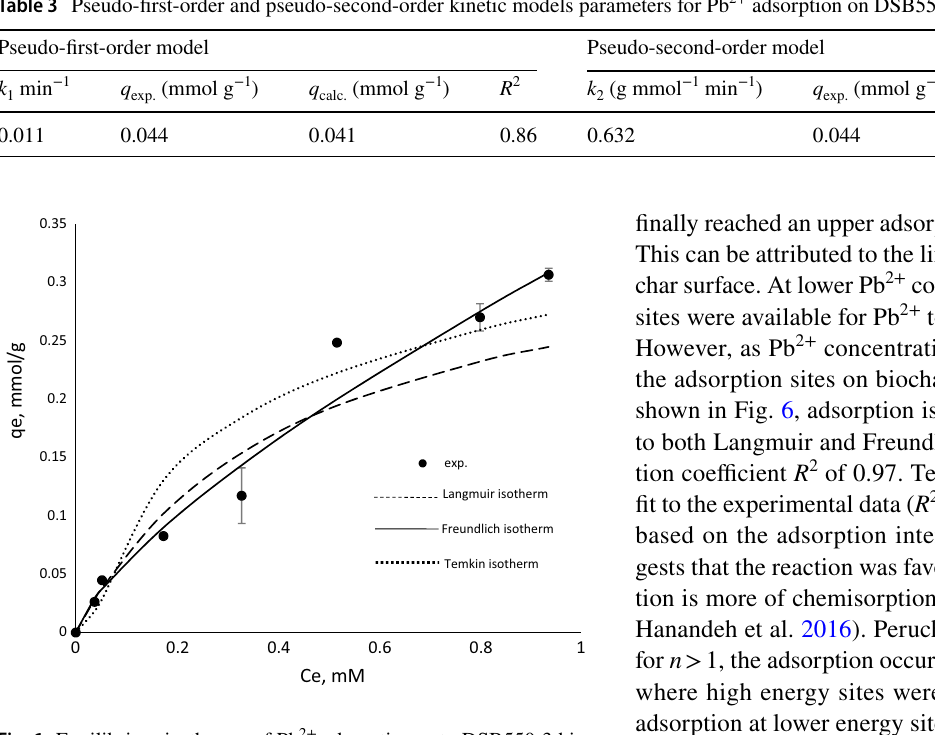
Fig. 6 Equilibrium isotherms of Pb 2+ adsorption onto DSB550-3 bio- char (initial concentration = 0.3–4.0 mM; pH 6; time = 24 h; biochar: solution ratio = 10 g L −1 ; particle size = 0.6–1.4 mm)